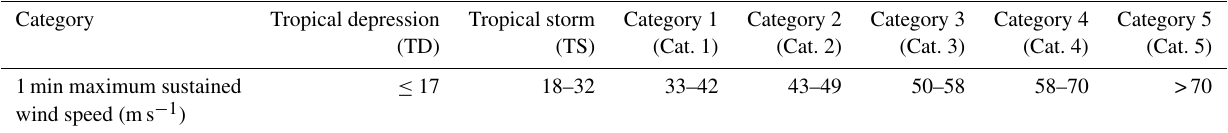
Table 2. TC intensity based on the Saffir–Simpson Hurricane Wind